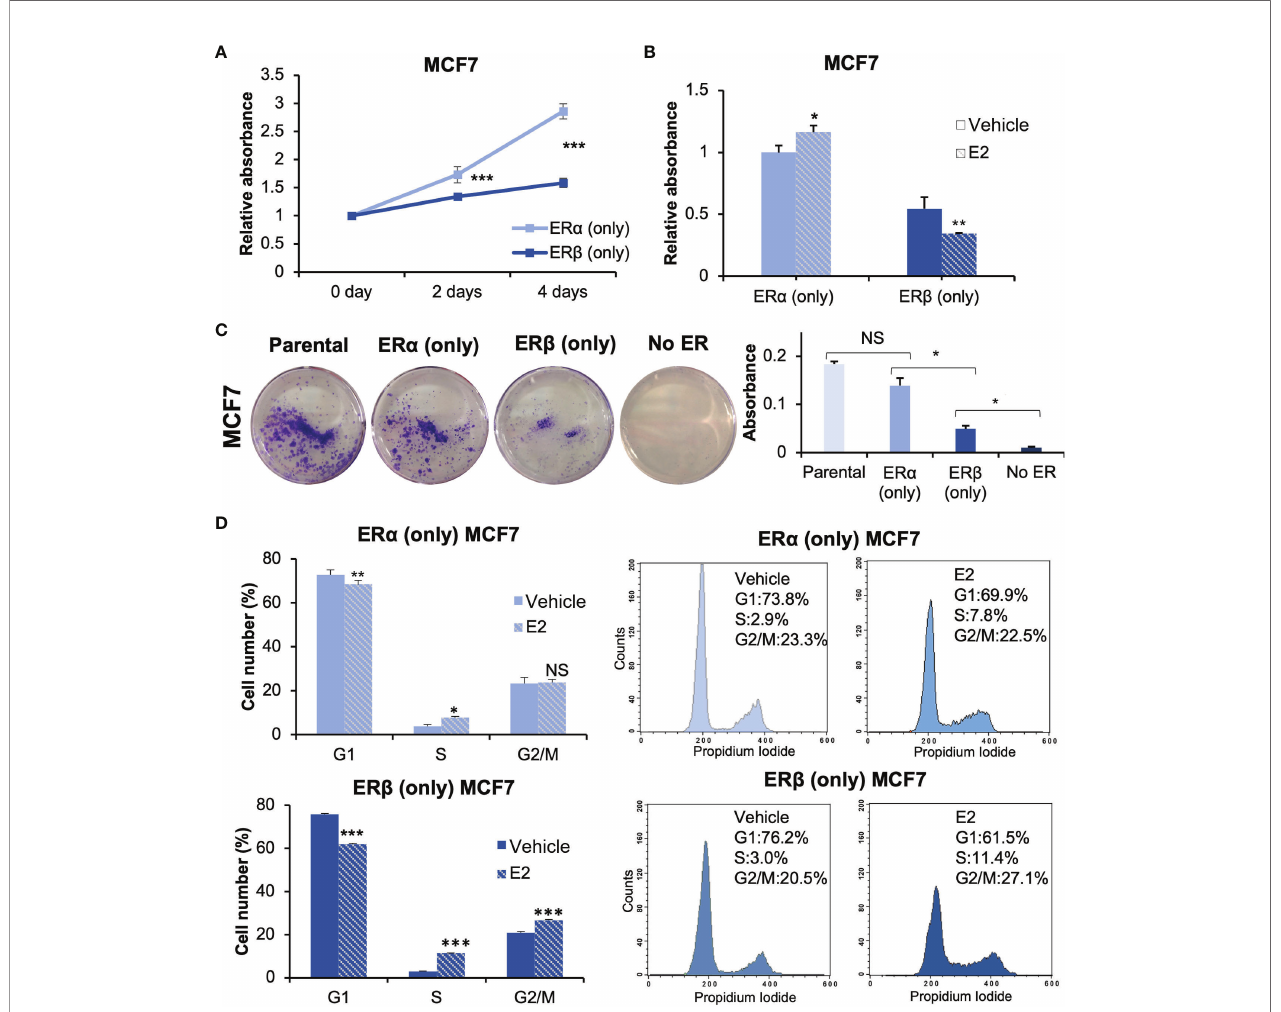
FIGURE 2 | ER a and ER b impact cell proliferation differently. (A) Cell proliferation of ER a (only) or ER b (only) MCF7 cells was measured using WST-1 assay. Cells were grown in full-serum medium and measured at day 0, 2, and 4. Absorbance at day 0 was used for normalization. (B) The cell lines were pre-cultured under non- estrogenic and serum-starved conditions, followed by E2 or vehicle treatment and measured by WST-1 assay at day 4. Absorbance of ER a (only) MCF7 cells with vehicle stimulation was used for normalization. (C) For clonogenic assay, the cells were cultured in full-serum medium for 8 days. Extracted crystal violet was used for quanti fi cation (right). (D) Flow cytometry analysis of cell cycle progression of ER a (only) or ER b (only) MCF7 cells (right) and corresponding quantitation of cell cycle distribution (G1, S and G2/M, left). Cells were grown in 2.5% DCC-FBS medium for 72 h, followed by treatment of E2 or vehicle for 24 h. Data is illustrated as means ± SD (n=3). A, B, D were analyzed using two-way ANOVA followed by Bonferroni test; C was analyzed using one-way ANOVA. * P < 0.05, ** P < 0.01, *** P < 0.001, NS, not signi fi